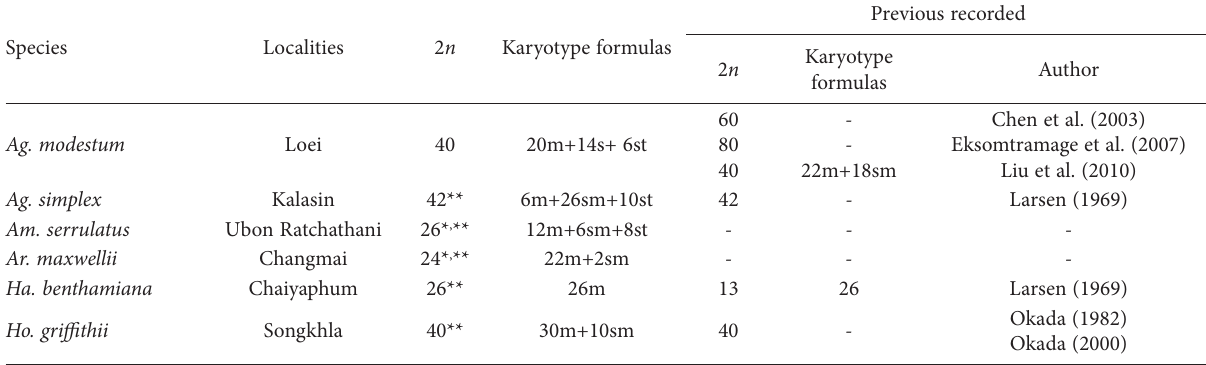
Table 1. Summarizes of the cytogenetic reviews of studies in six species of the Araceae family in Thailand.